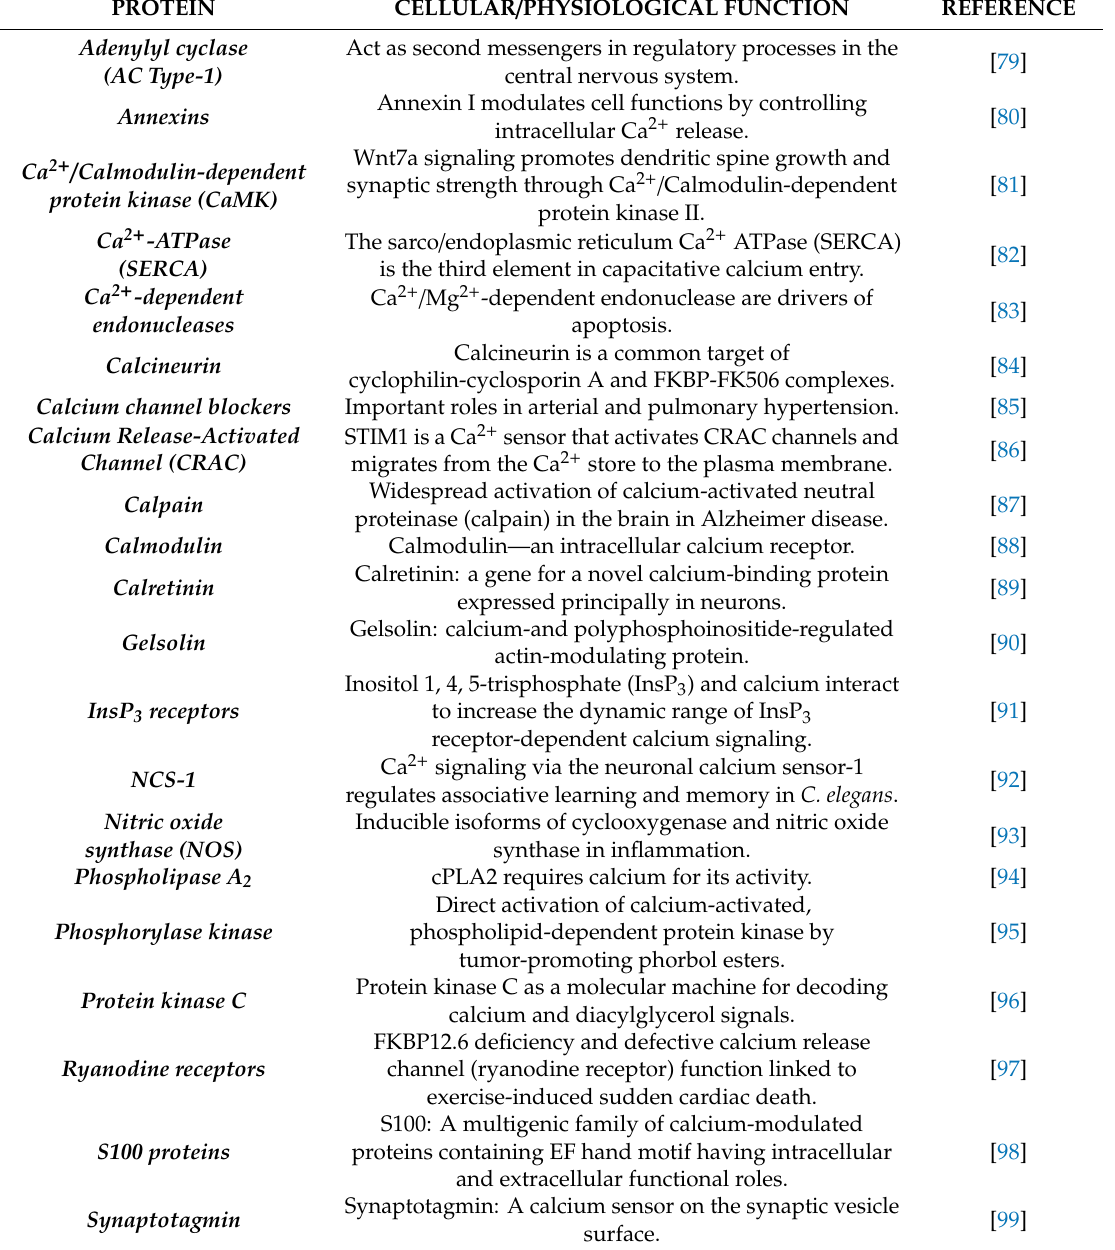
Table 1. Summarizes some protein that regulate calcium signaling in diverse cell